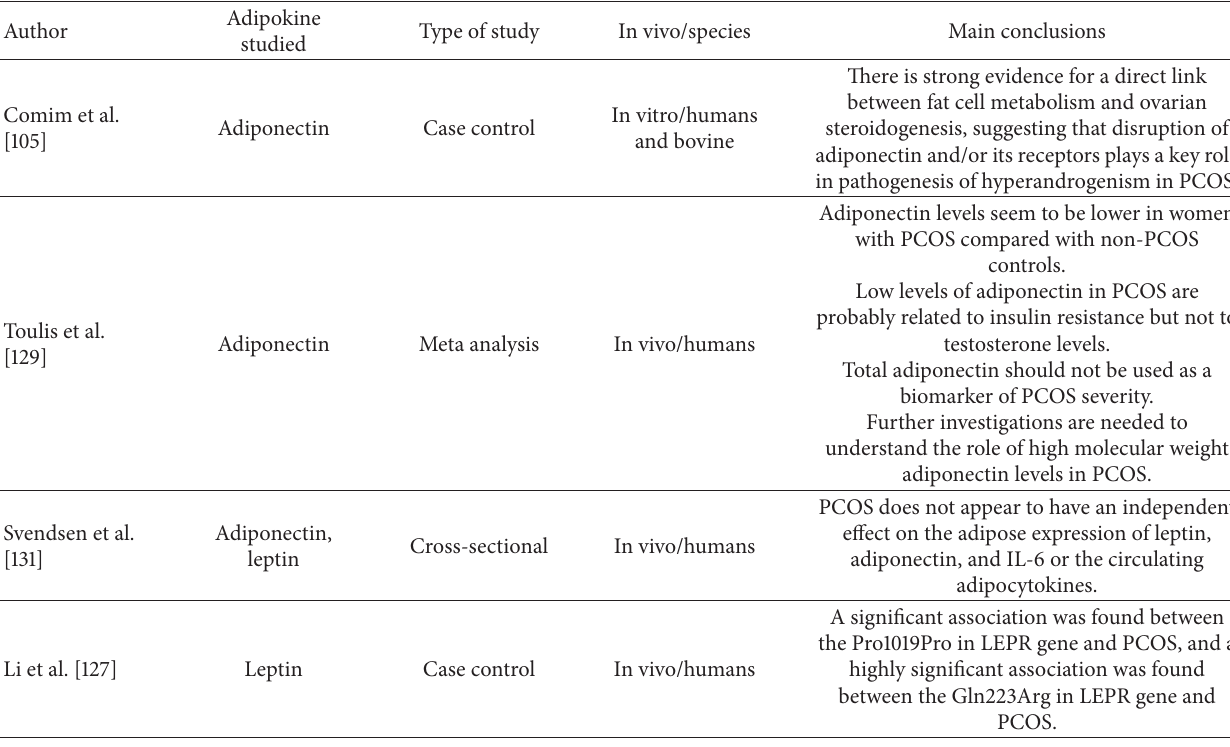
Table 4: Main findings published in the literature concerning the relationship between adiponectin, leptin and onset of PCOS.